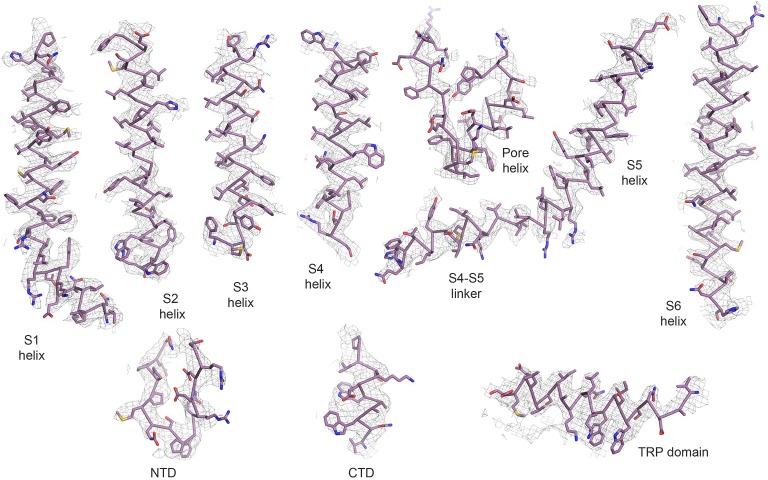
Representative densities from the TRPV2APO_2 cryo-EM map.Densities are contoured at σ = 5.